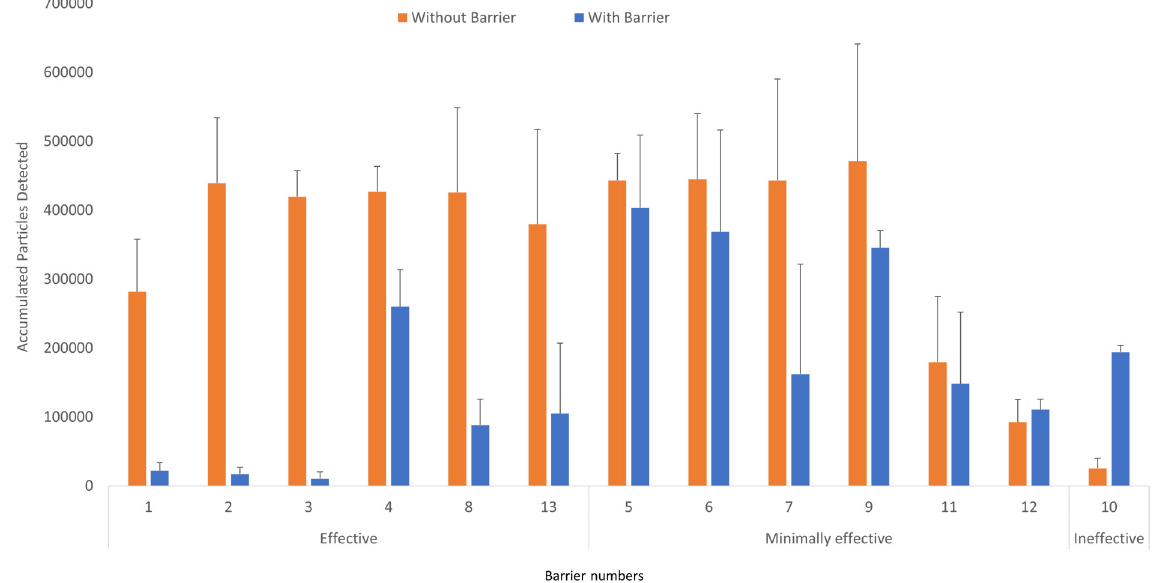
Figure 1. Accumulated number of 5% sodium chloride aerosol particles detected over 2 minutes with versus without a plexiglass barrier in place. The aerosol particles were released at 91 cm from the barrier. Average results for 3 experiments are shown. Error bars represent standard error. Effective barriers significantly reduced particle exposure; minimally effective barriers reduced exposure but not significantly; the ineffective barrier resulted in a significant increase in exposure.